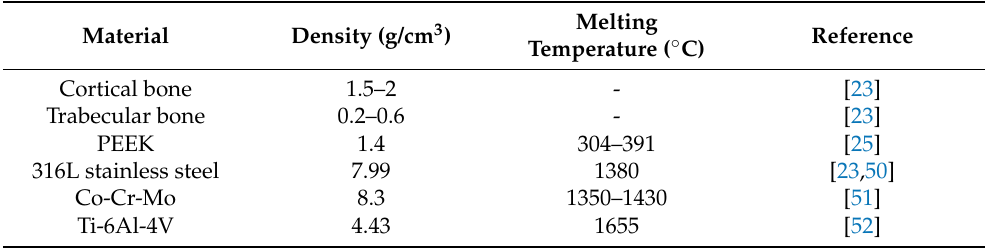
Table 1. Density and melting temperature of bone, PEEK, and metal alloys traditionally used in orthopedic implants.